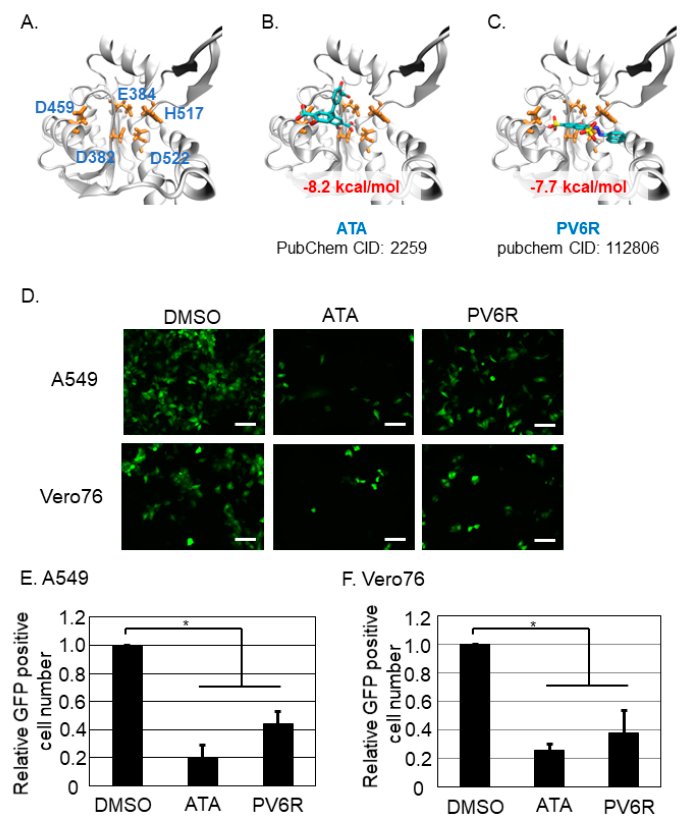
Figure 2. Both ATA and PV6R inhibited the post ‐ entry step of the LCMV infection. ( A ) The structure of the DEDDh motif of LCMV NP. Amino acid number which corresponded to the DEDDh motif was described in BLUE font, together with the amino acid number. ( B ) Docking simulation of the ATA and the DEDDh motif of LCMV NP. ( C ) Docking simulation of the PV6R and the DEDDh motif of LCMV NP. ( D ) Either A549 cells or Vero 76 cells were infected with 3rLCMV/GFP and treated with DMSO, ATA, or PV6R. At 20 h post infection, the cells were fixed and the GFP positive cells were observed with the fluorescent microscope. Bar; 100 μ m. GFP positive cell number in A549 ( E ) and in Vero 76 ( F ) were counted and normalized with the GFP positive cell number in DMSO control treatment as 1.0. Data were collected from at least three independent experiments, and shown data correspond to the mean +/ − SD (*; p < 0.05).